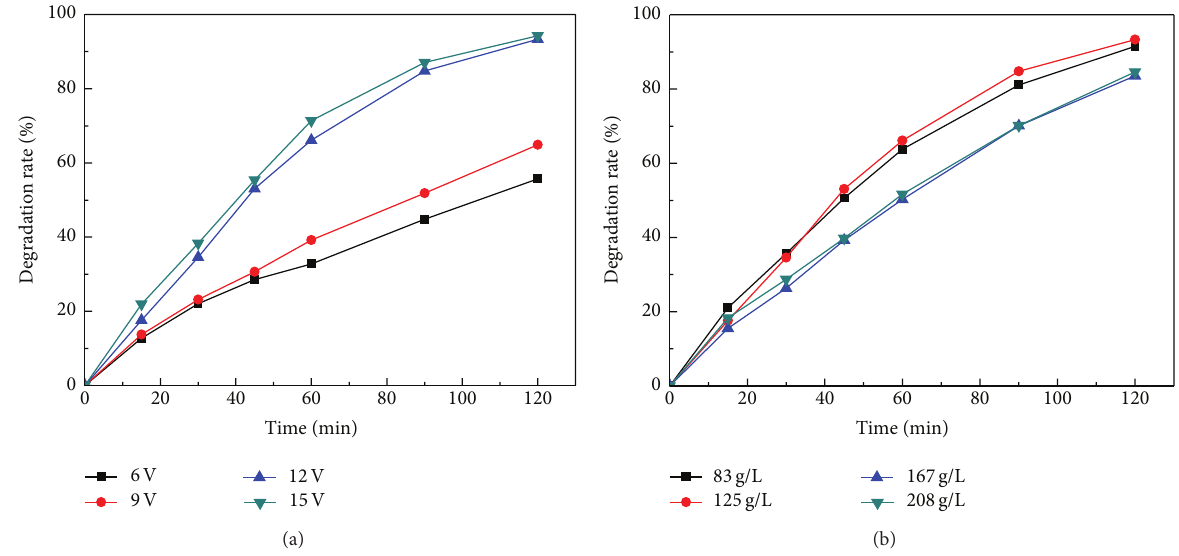
Figure 8: (a) Electrocatalytic performance of the sample: (a) at different electrolytic voltage; (b) at different dosage concentration of particle electrode.